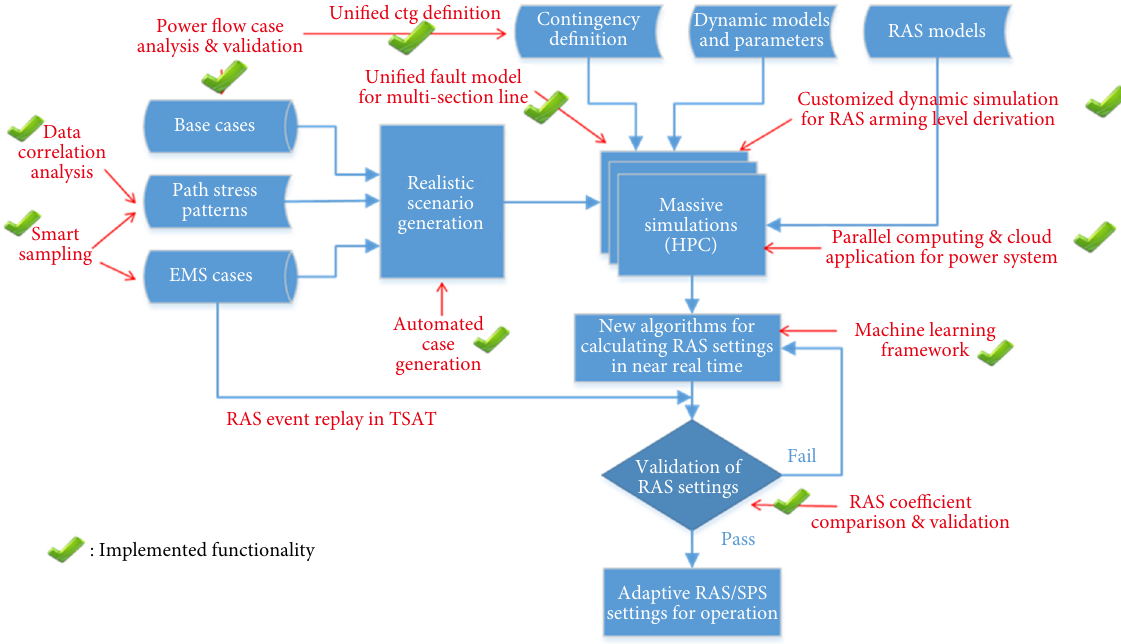
Fig. 10 Overview of data-driven analytical functionalities in TRAST. Reprinted with permission from ref. [36] © Battelle Memorial Institute